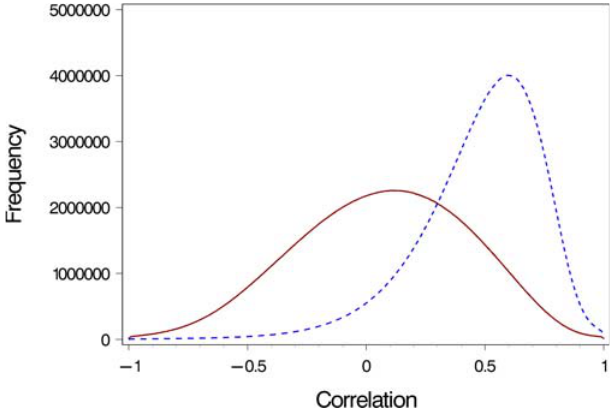
Figure 2. Impact of Normalization on the Correlation Distributions Normalization results in a distribution approximately centered around zero.